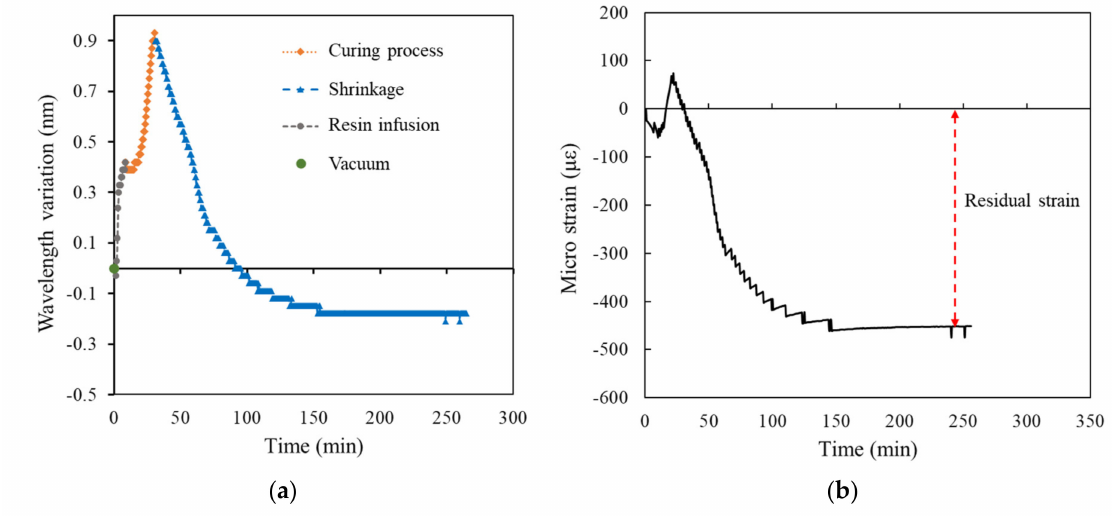
Figure 10. Experimental results of surface laminate-stacking number is 10. ( a ) Wavelength-variation varying with time. ( b ) Residual strain.